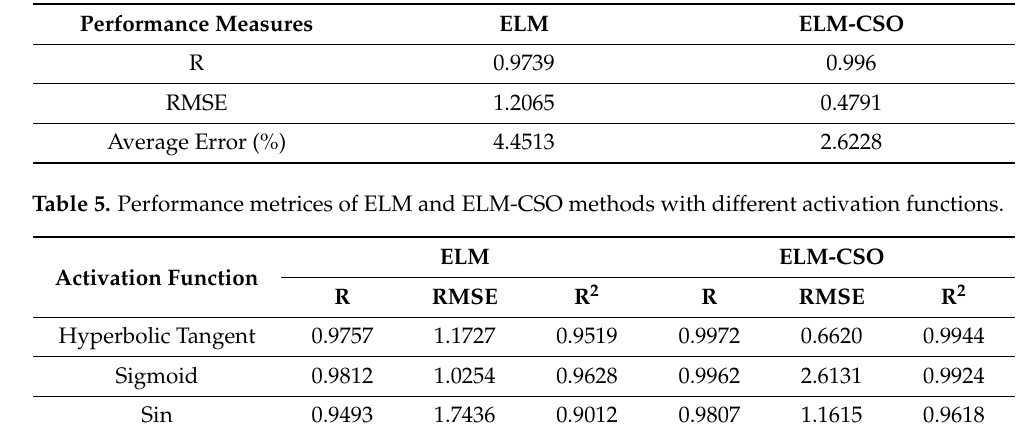
Figure 7. CBR prediction using algorithm with missing data ( a ) ELM-CSO, ( b ) ELM. Table 4. Performance metrices comparison of ELM and ELM-CSO with missing data.